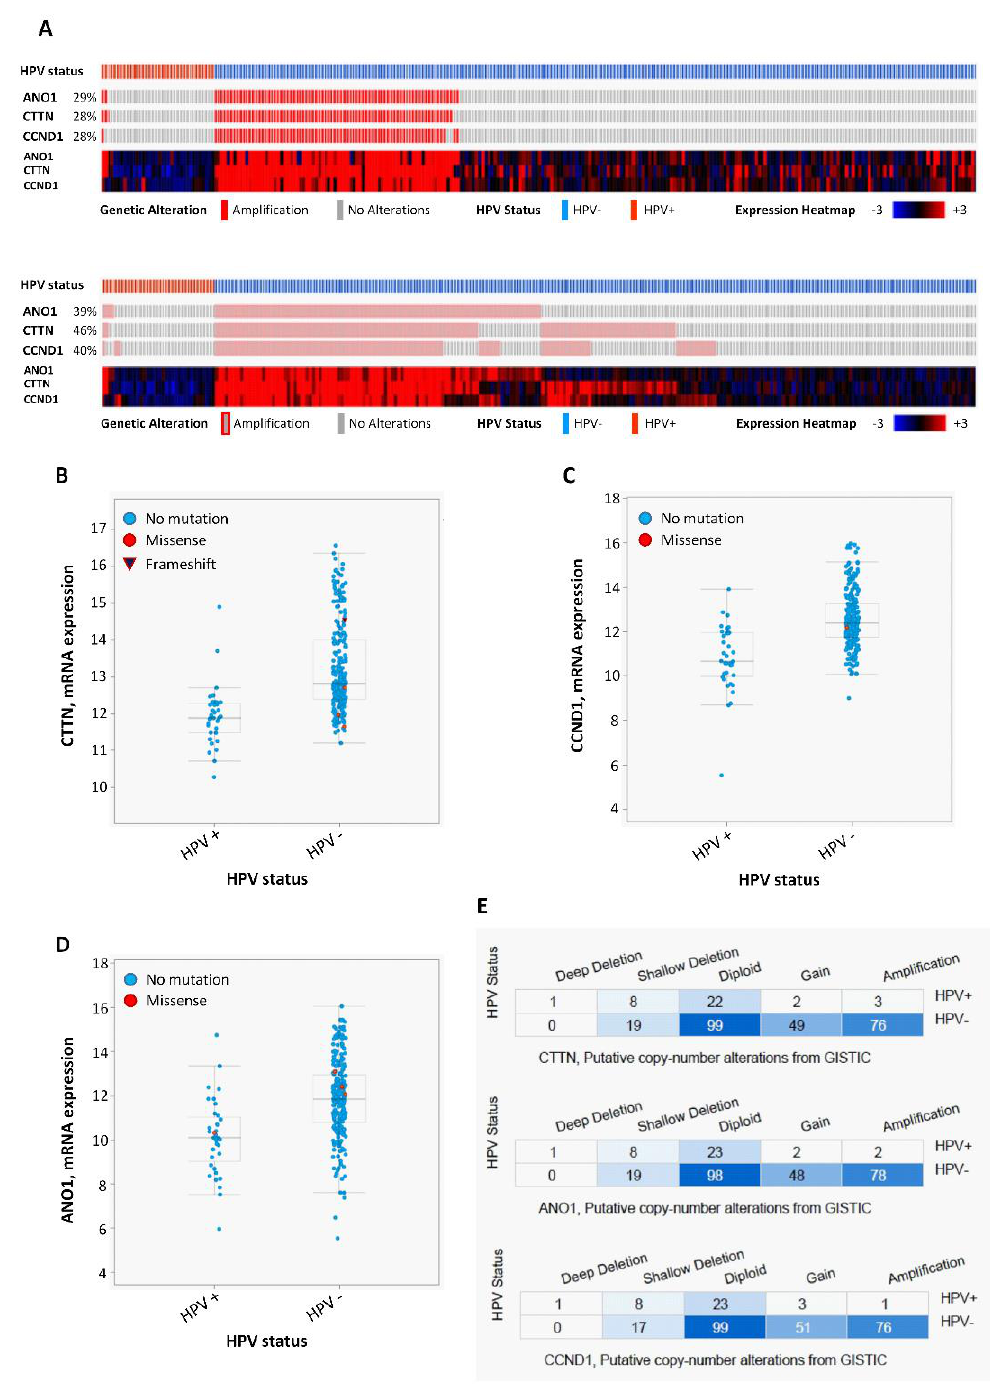
Figure 4. Analysis of mRNA expression and copy number alterations of CTTN , CCND1 and ANO1 in relation to HPV status related to the available HNSCC TCGA data ( n = 279) obtained from cBioPortal. ( A ) Schematic representation and heat map showing the percentage of cases with CTTN, CCND1 , and ANO1 gene amplification and mRNA expression in relation to the HPV status. ( B ) CTTN, ( C ) CCND1, and ( D ) ANO1 mRNA expression distributed according to the HPV status. mRNA expression (RNA seq V2 RSEM) values were Log2 transformed ( y -axis). Whiskers plot (min. to max.) with median values; p < 0.001, two-tailed Student t -test. ( E ) Copy number alterations of CTTN , CCND1 and ANO1 according to the HPV status using the GISTIC method.